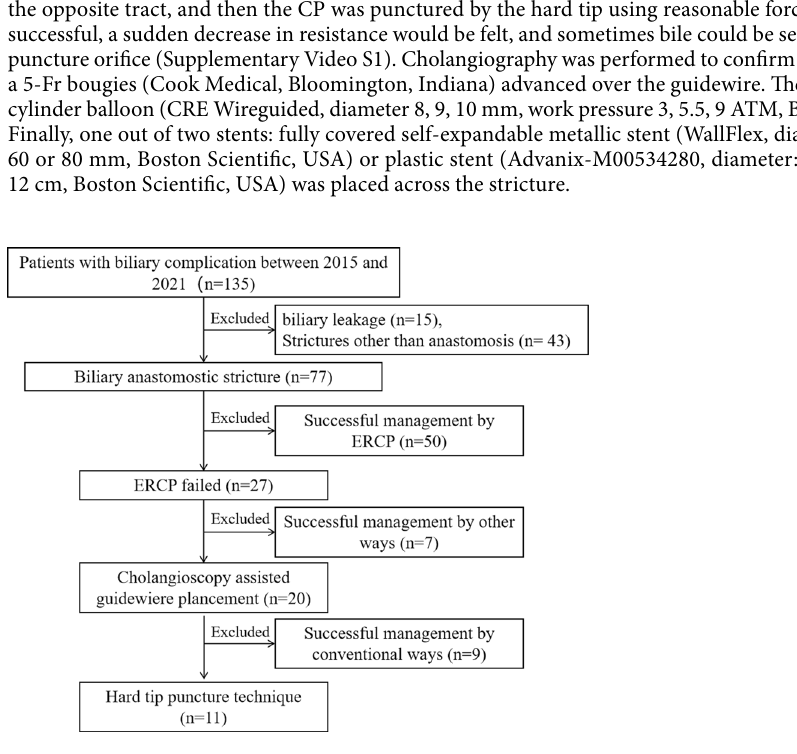
Figure 1. Flow diagram for enrollment of patients in the study. ERCP endoscopic retrograde